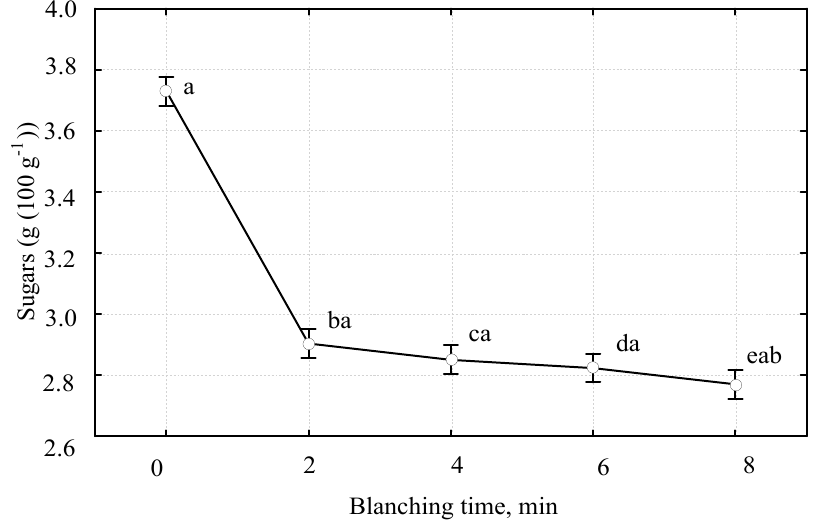
Figure 2. The influence of the blanching time on sugar content including 95% confidence intervals. Means with the same letter are significantly different from each other ( p < 0.05).